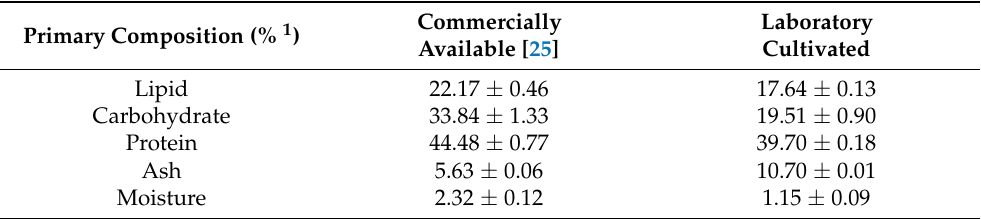
Table 1. Primary composition of the commercially available and laboratory cultivated C. vulgaris biomass [25].